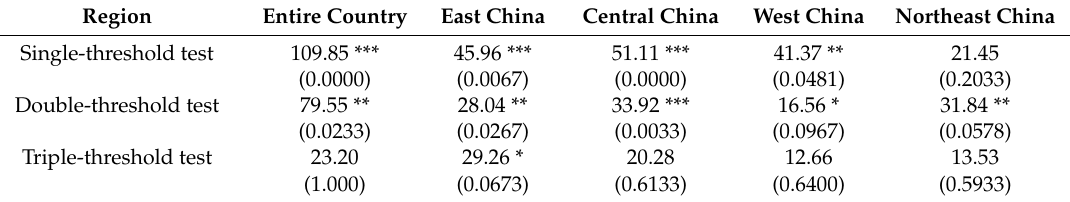
Table 5. Threshold e ff ect test.